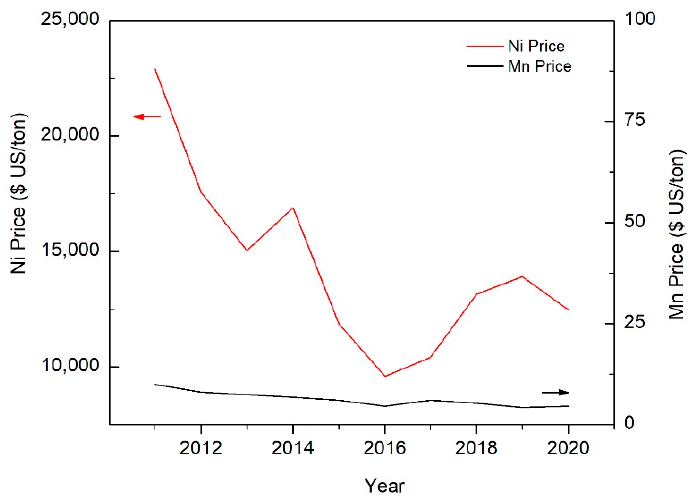
Figure 5. Average price ($US/ton) for Ni and Mn metals over the last decade (2011 − 2020).